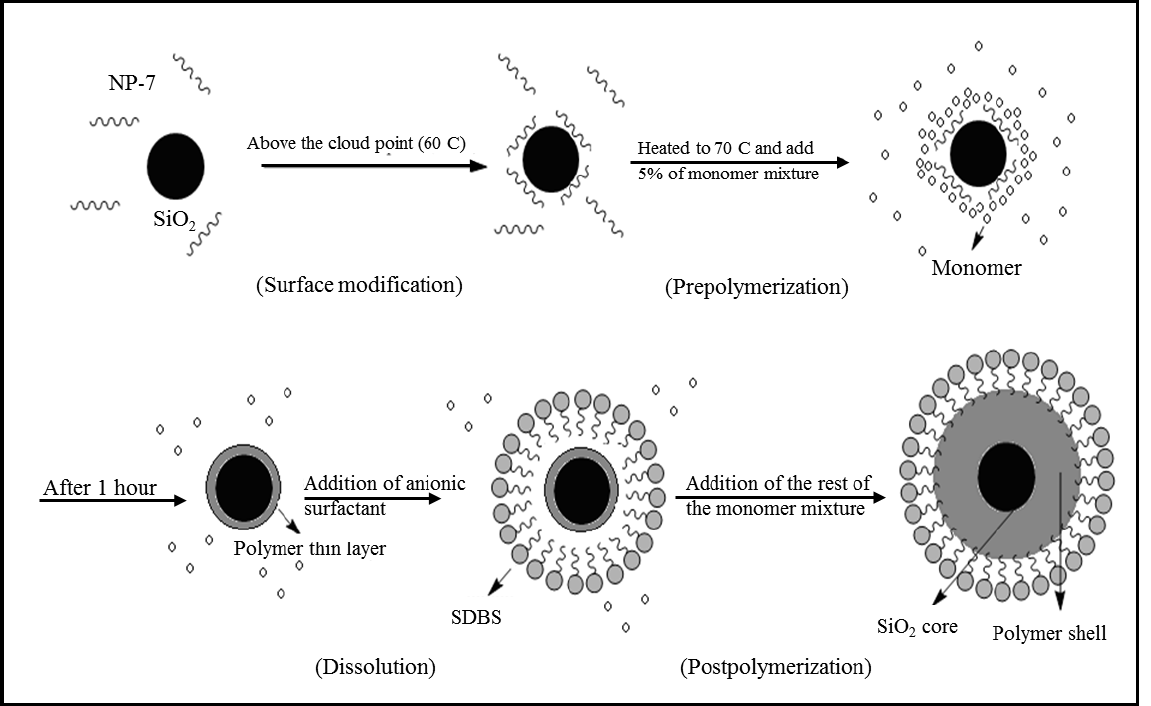
Figure 1. Schematic mechanism of the formation process of encapsulated nanosilica particles with the acrylic copolymer by in situ emulsion polymerization using thermoresponsive nonionic